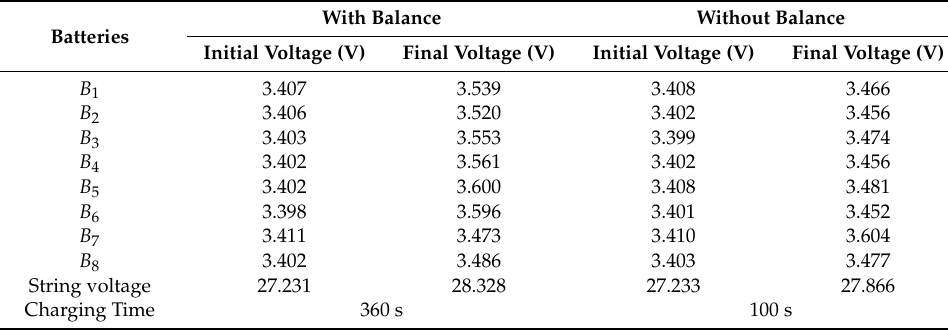
Figure 12. Variation in voltage when charging: ( a ) with balancing; ( b ) without balancing. Table 4. Battery voltages when charging with/without the balance operation.